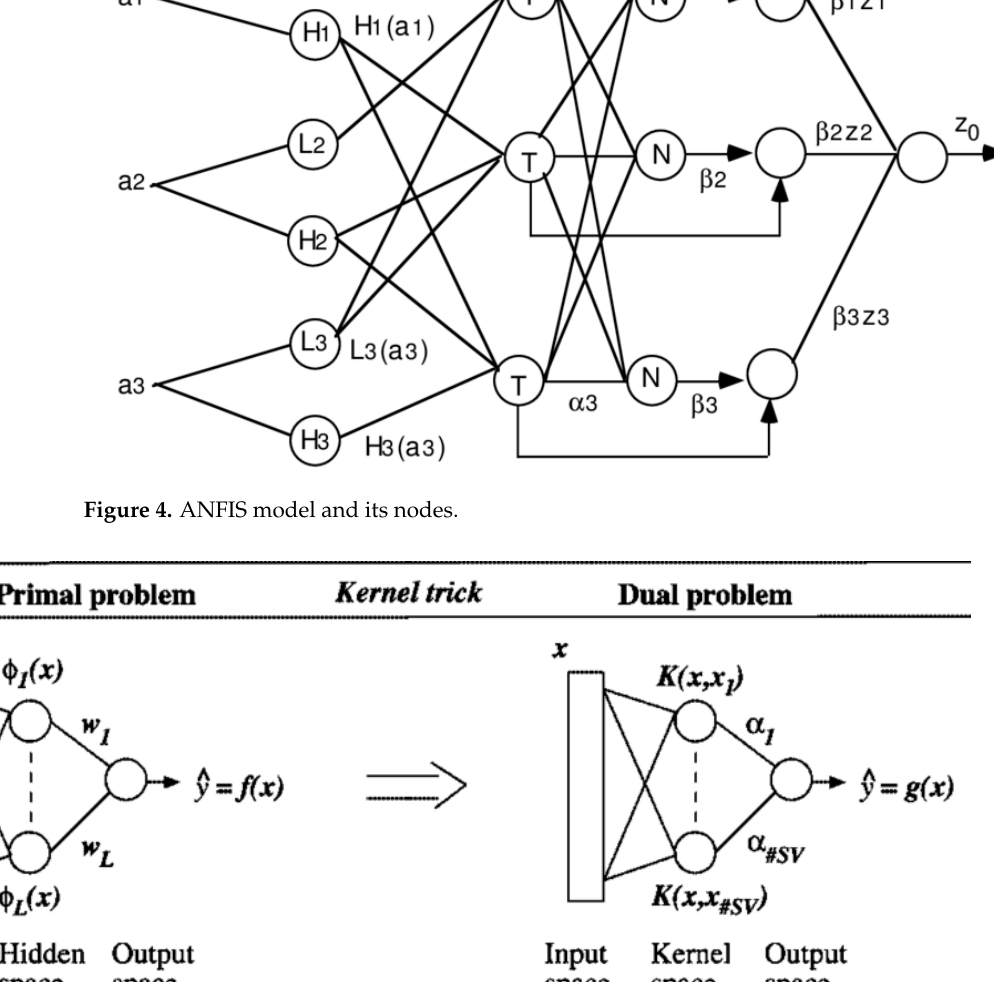
Figure 5. SVM model.